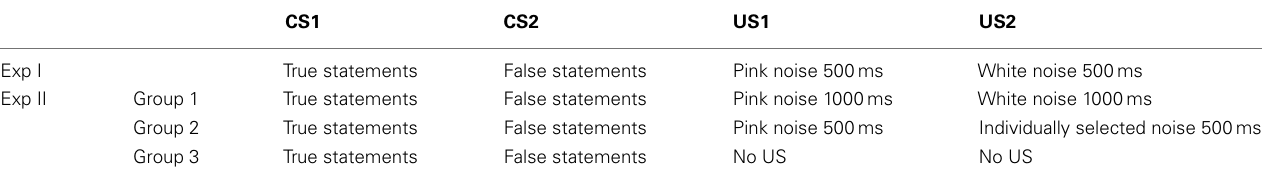
Table 2 | Description of the paradigms for Exp I and Exp